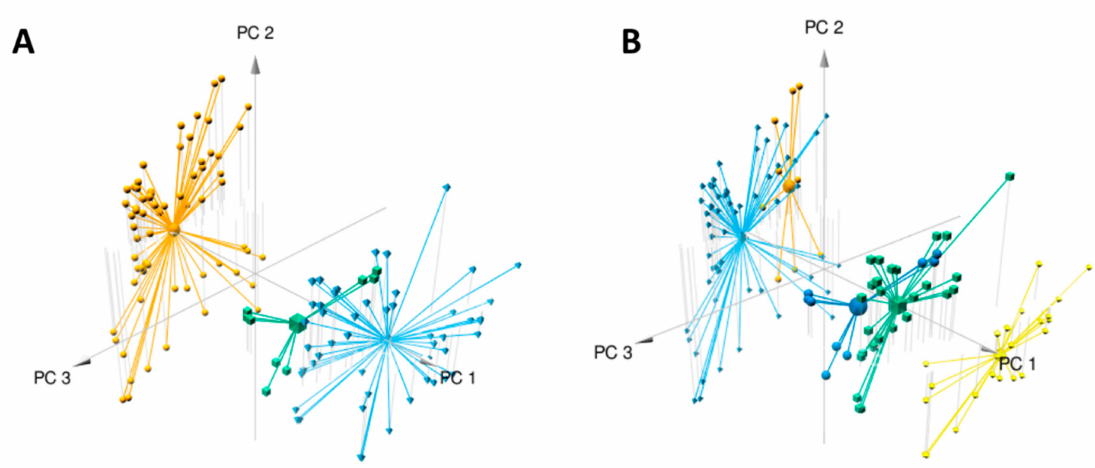
Figure 2. Multivariate modeling using PCA of metabolomics variation in samples from Erythrophleum species ( E. ivorense and E. suaveolens ). The three first components are plotted and percentages of variance explained by PC1, PC2 and PC3 are respectively 49%, 8% and 7%. R 2 X of the PCA model is 0.648. ( A ) Samples are colored corresponding to the three groups based on species E. ivorense (ivo) in orange, E. suaveolens North (sua(N)) in blue and E. suaveolens South (sua(S)) in green (see Table 1 for details). ( B ) The PCA was drawn with groups identified in the heatmap as a grouping factor (see Figure 3). In